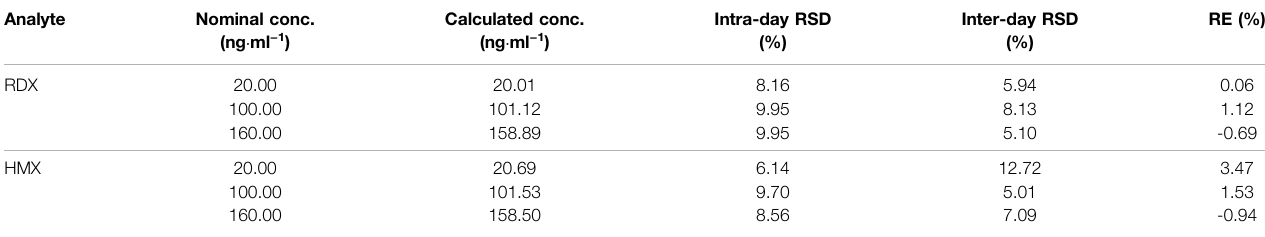
TABLE 3 | Precision and accuracy for determination of RDX and HMX in rat plasma.